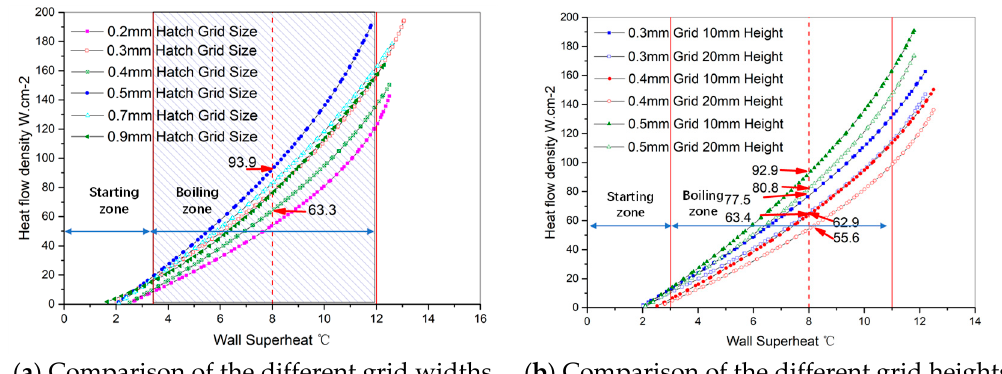
Figure 10. Saturated boiling curves of the grid structures with different widths and heights.